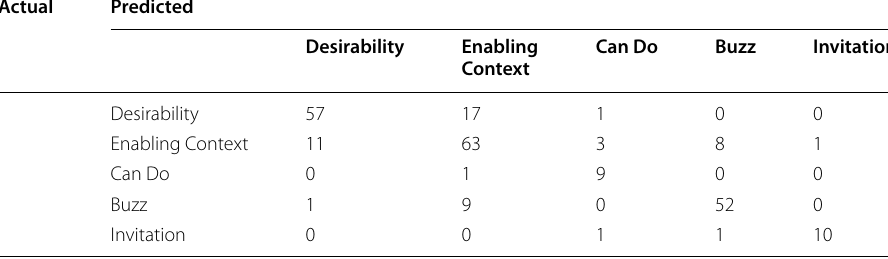
Table 12 Confusion matrix BERTweet stacking ensemble scenario SE#11